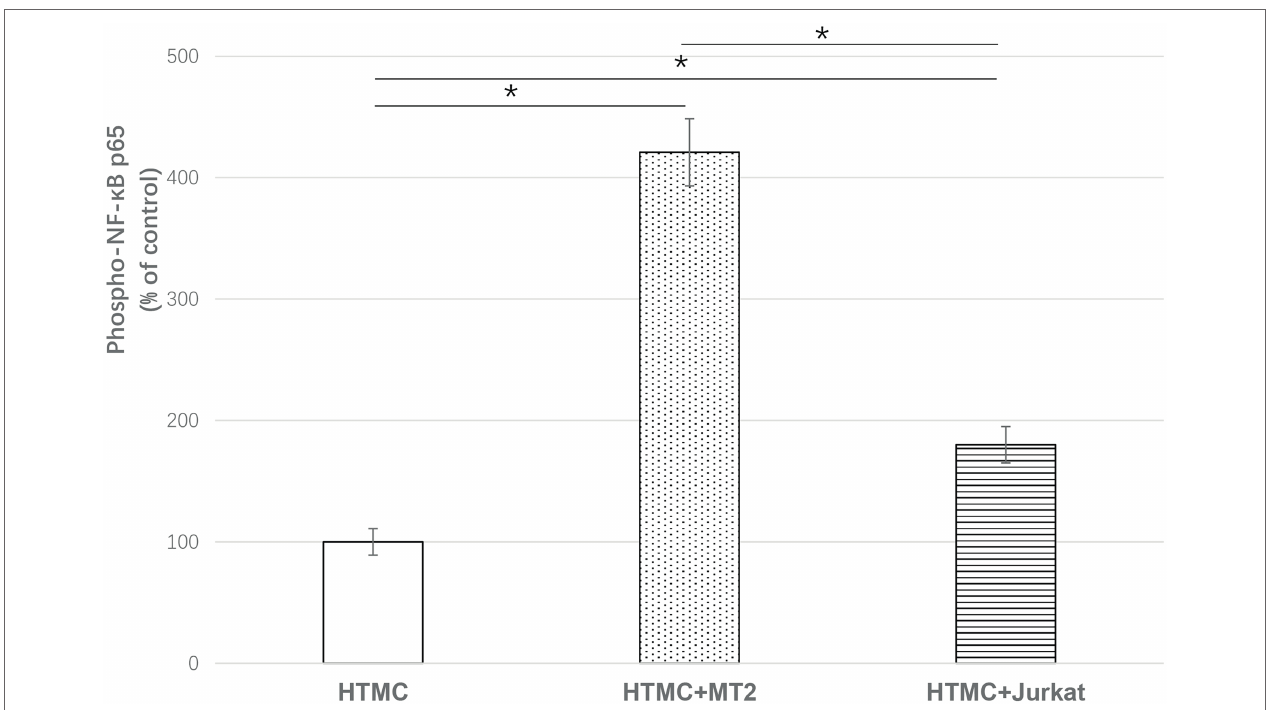
FIGURE 5 | ELISA of phospho p65NFKB to show the effect of HTLV-1 infection on activation of NF- κ B in HTMCs after three transfers. Data are expressed as percent of the control (%). Compared with HTMCs cultured alone, HTMCs co-cultured with irradiated MT-2 cells or irradiated Jurkat cells exhibited significantly increased phospho p65 NF- κ B expression. Among the co-culture groups, HTMCs co-cultured with MT-2 cells exhibited significantly increased phospho p65NF- κ B expression compared with HTMCs co-cultured with Jurkat cells. Error bars represent standard deviation (* p < 0.05; n.s., not significant).